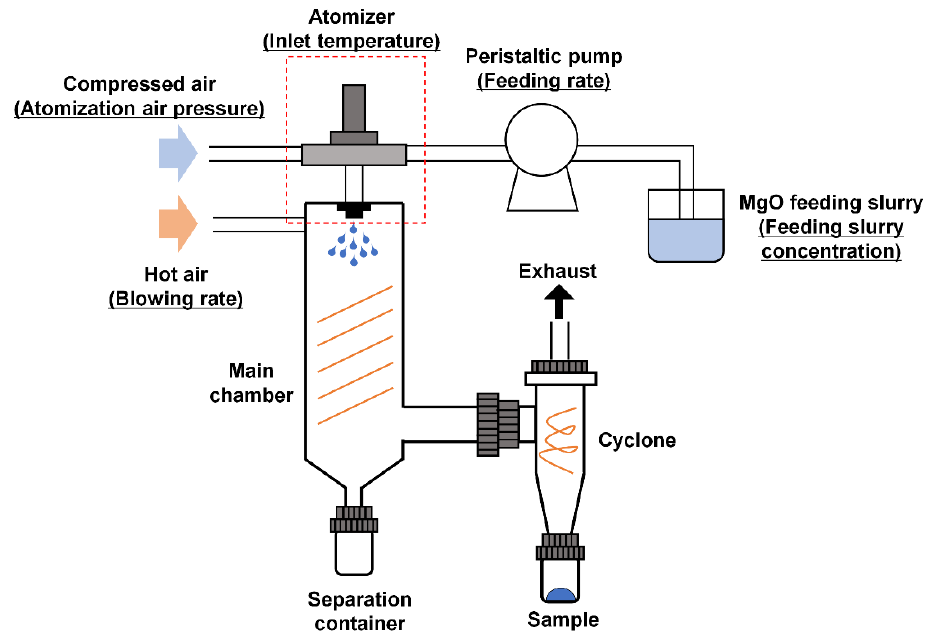
Figure 7. Schematic diagram of the spray-drying